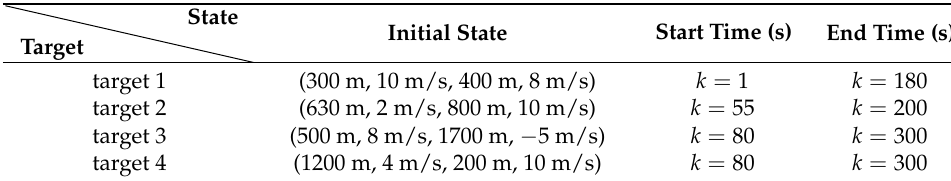
Table 1. The state parameters of targets.